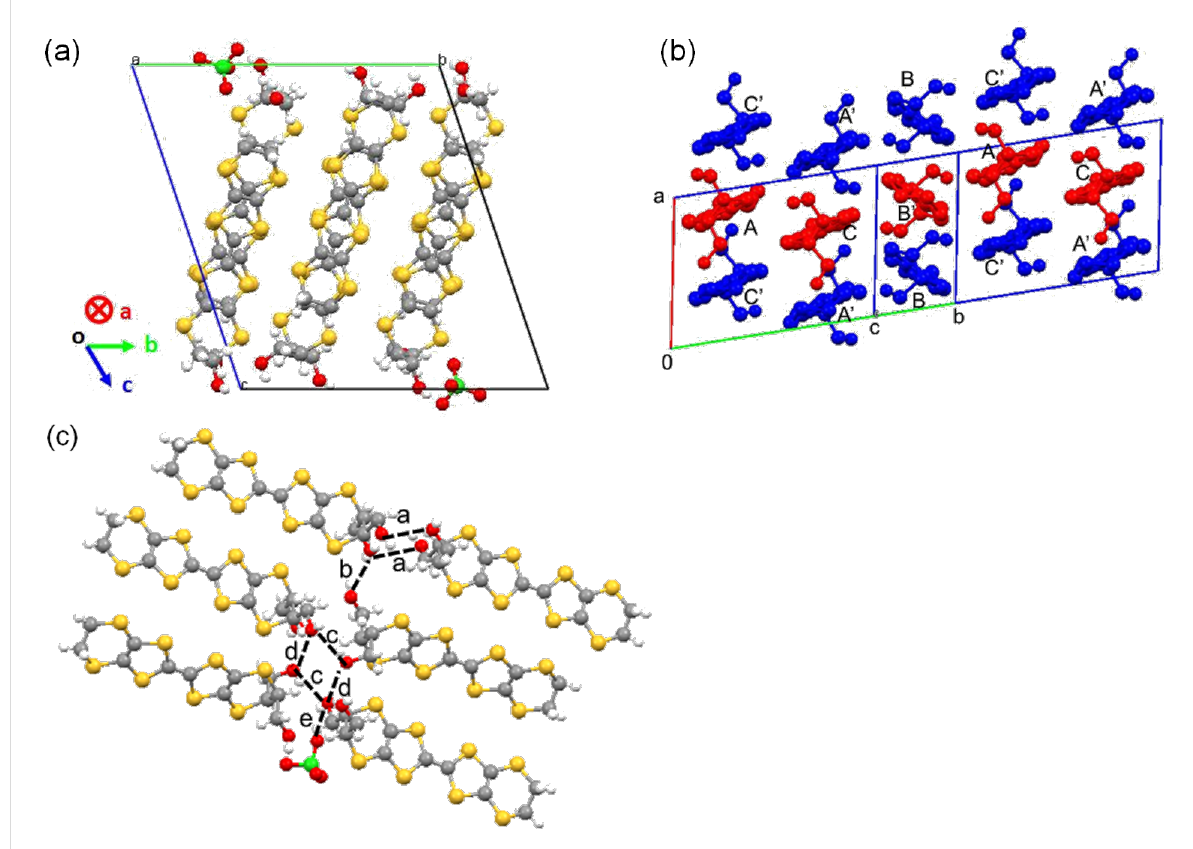
Figure 2: (a) Crystal structure, (b) θ 21 -type donor arrangement of molecules A and A’ [( S,S ) and ( R,R )- 2 indicated by red and blue with charge of +0.59(8)], B and B’ [( R,R ) and ( S,S )- 2 , blue and red with +0.23(7)], and C and C’ [( S,S ) and ( R,R )- 2 , red and blue with +0.18(8)], and (c) O···O hydrogen bond contacts of achital charge transfer salt θ 21 -[( S,S )- 2 ] 3 [( R,R )- 2 ] 3 (ClO 4 ) 2 ; a = 2.89(1), b = 2.90(1), c = 2.879(8), d = 2.837(8), e = 2.94(1)